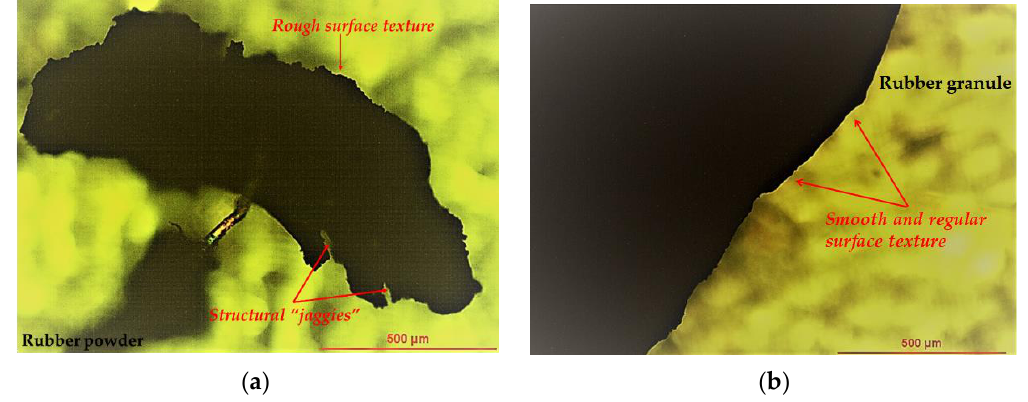
Figure 9. Surface texture of GTR aggregates: rubber powder ( a ) and rubber granule ( b ).